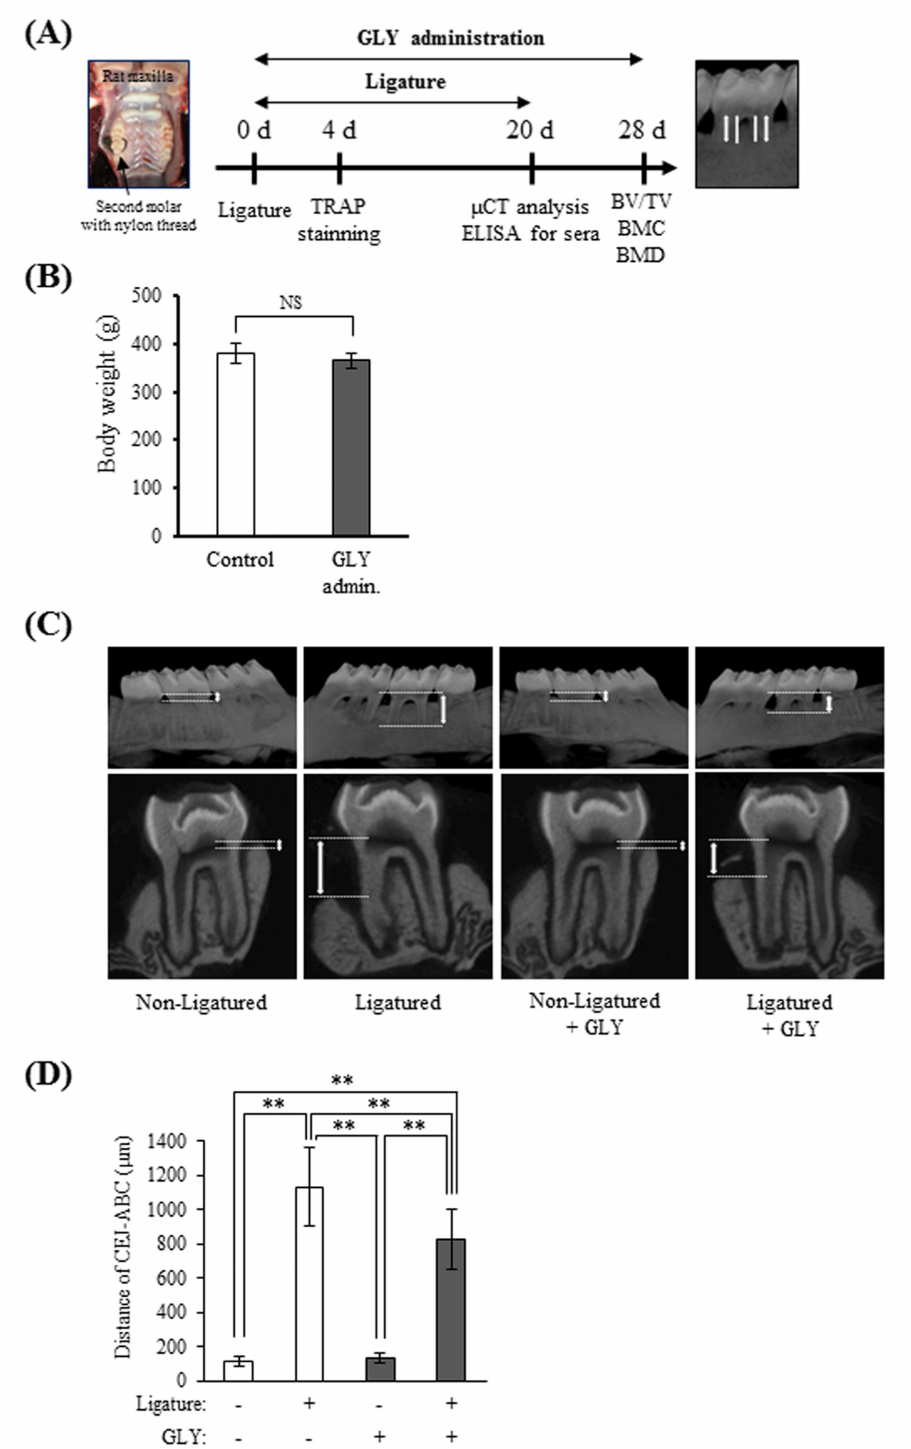
Figure 4. The effects of GLY extracts on bone resorption in ligature-induced periodontitis. ( A ) Experimental design and the points of linear measurement of the cement-enamel junction (CEJ) to the alveolar bone crest (ABC) by micro-CT analysis. ( B ) Body weights of rats on day 20 from the placement of ligature. Control; group of oral administration of distilled water for 20 days ( n = 6), GLY admin.; group of oral administration with 60 mg/kg of GLY extracts for 20 days ( n = 12). ( C ) Representative micro-CT images of the frontal and sagittal sections of maxillary secondary molars from rats. ( D ) Distance from the CEJ to the ABC as a marker of alveolar bone resorption in micro-CT. Data are presented as the mean ± SD from six or twelve rats per group. Double asterisk indicates p < 0.01. NS indicates no significant